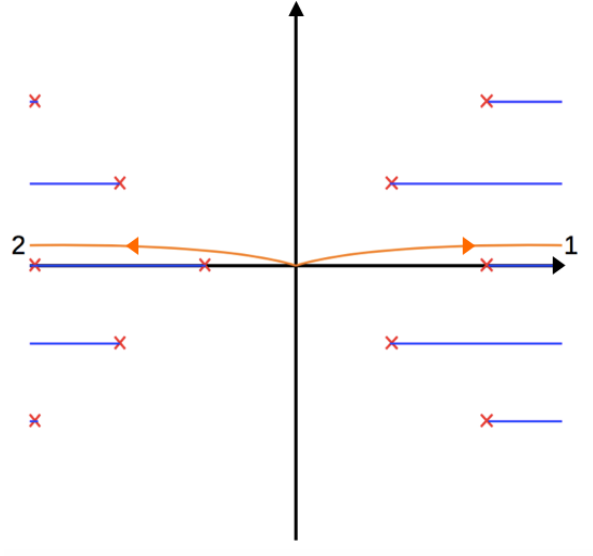
Figure 8. Contours of integration for the directed Laplace